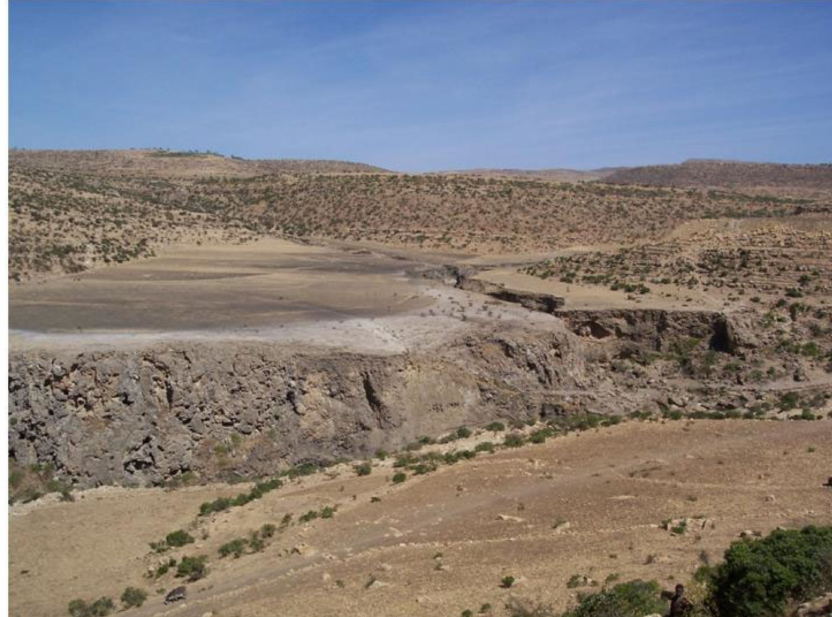
Figure 4. The imposing Holocene tufa dam of May Makden in Tigray (northern Ethiopian Highlands).